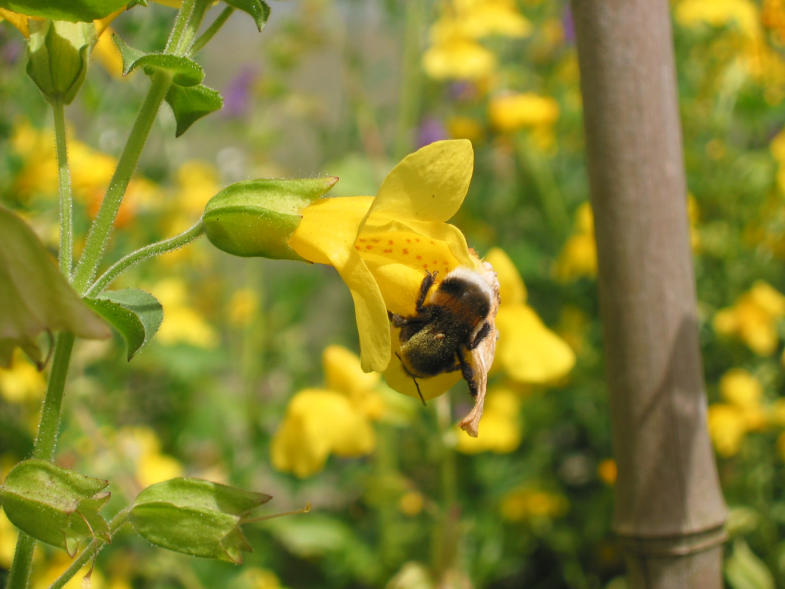
Loss of biodiversity in pollination networks may threaten the persistence of plant communities